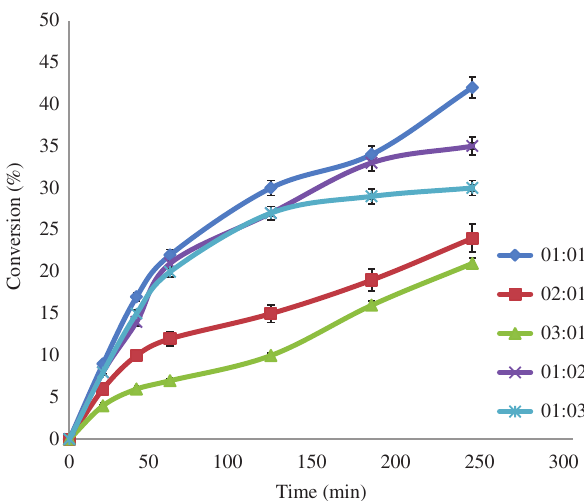
Figure 1: Effect of molar concentration of reactants on conversion at hexane 3 ml, enzyme loading 1% (w/v), temperature 50 ° C, agitation speed 100 rpm, power 100 W, duty cycle 80% and frequency 25 kHz.